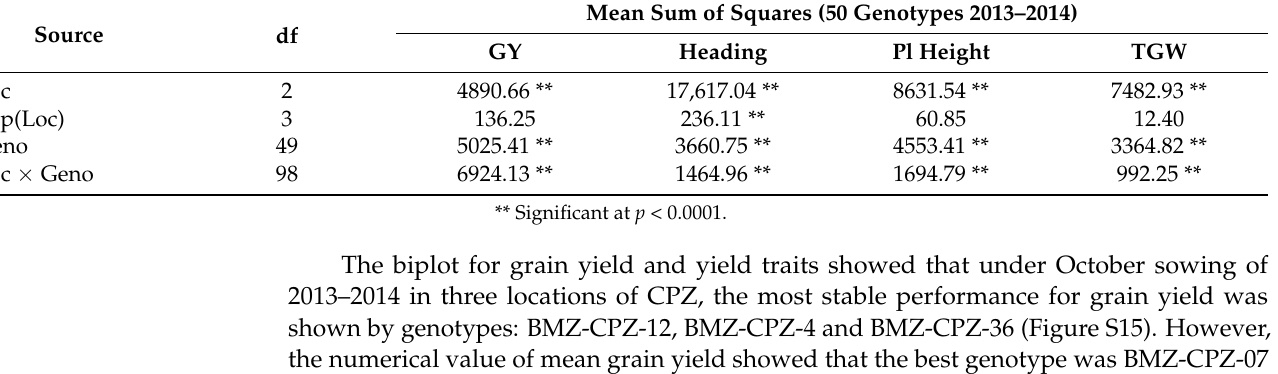
Table 5. Analysis of variance of grain yield and yield traits of wheat genotypes evaluated at three locations of CPZ of India under early (October) sowing conditions in